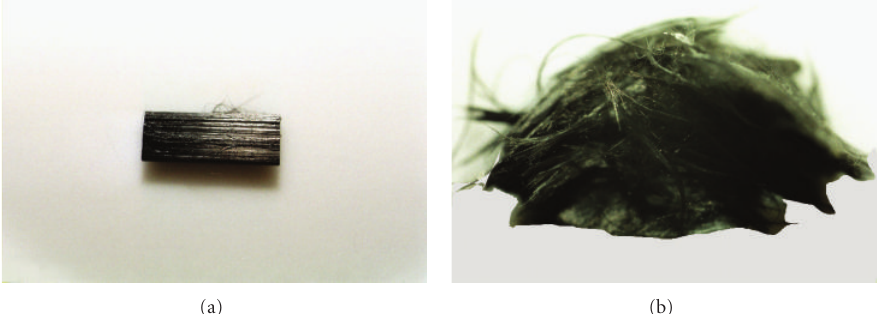
Figure 6: (a) Typical composite bar exposed to sulfuric acid, hydrochloric acid, or phosphoric acid. (b) Composite bar exposed to nitric acid over a similar time period then washed and